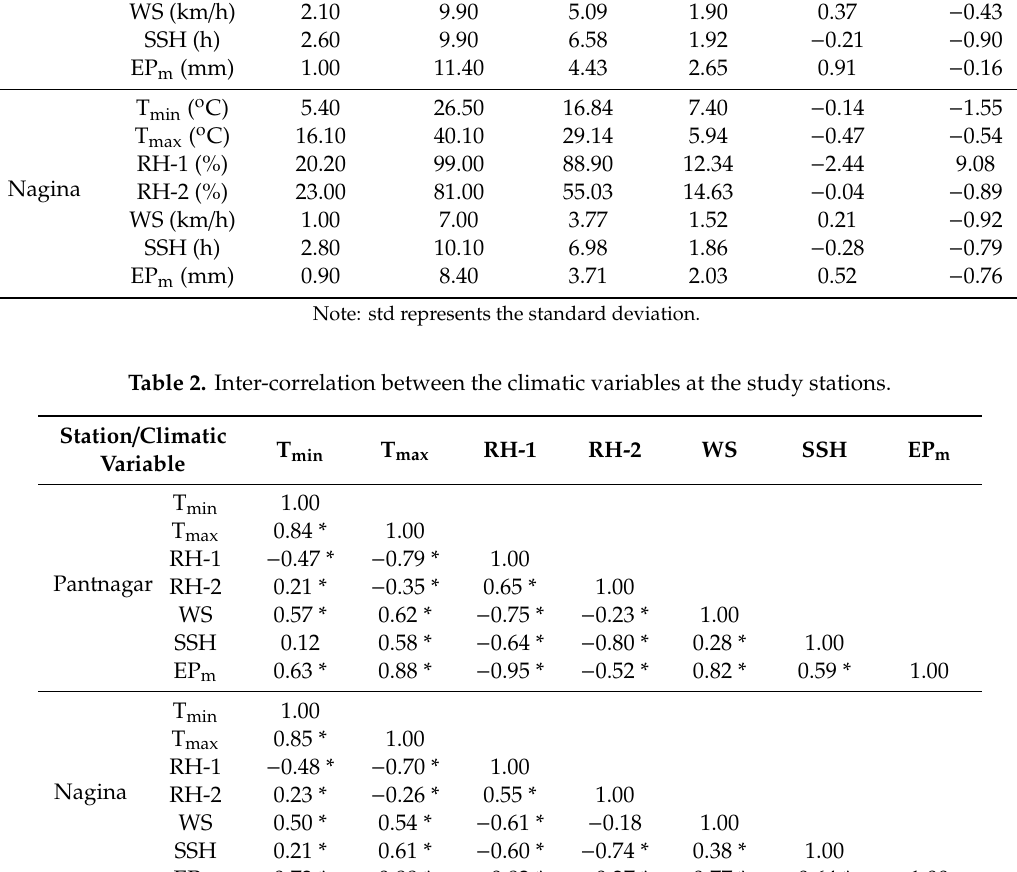
Table 1. Statistical constraints of climatic variables at the study stations during 2009–2016. Statistical Parameters Station / Climatic Variable Minimum